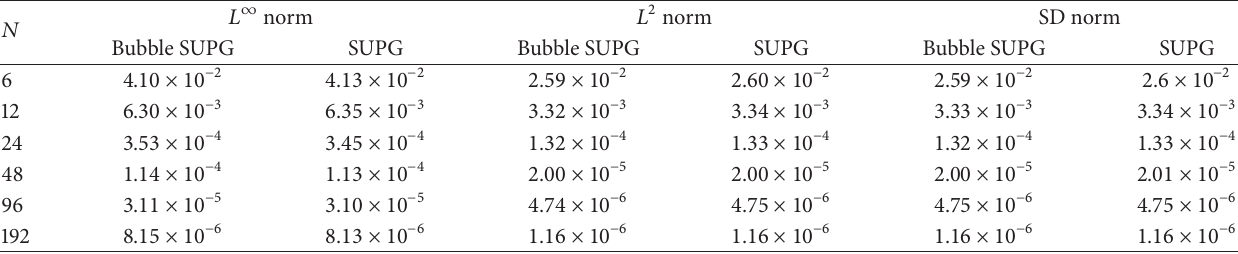
Table 1: 𝜀 = 10 −8 , Problem 1 (comparison of error).